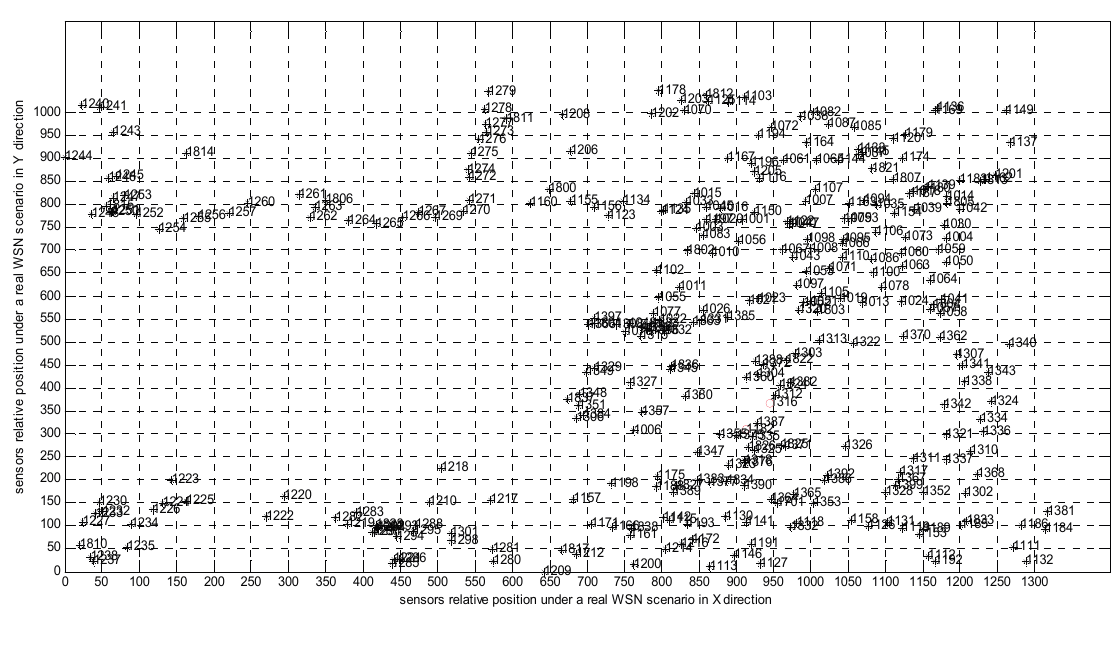
Figure 3. Hierarchical cluster topology in a real WSN